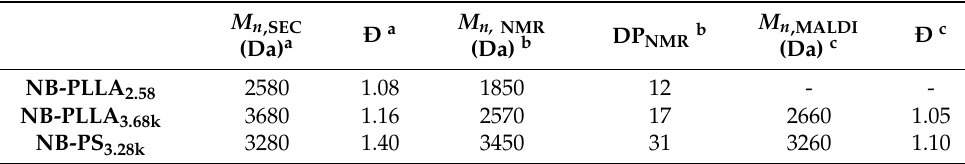
Table 1. Molecular characteristics of NB-PLLA and NB-PS